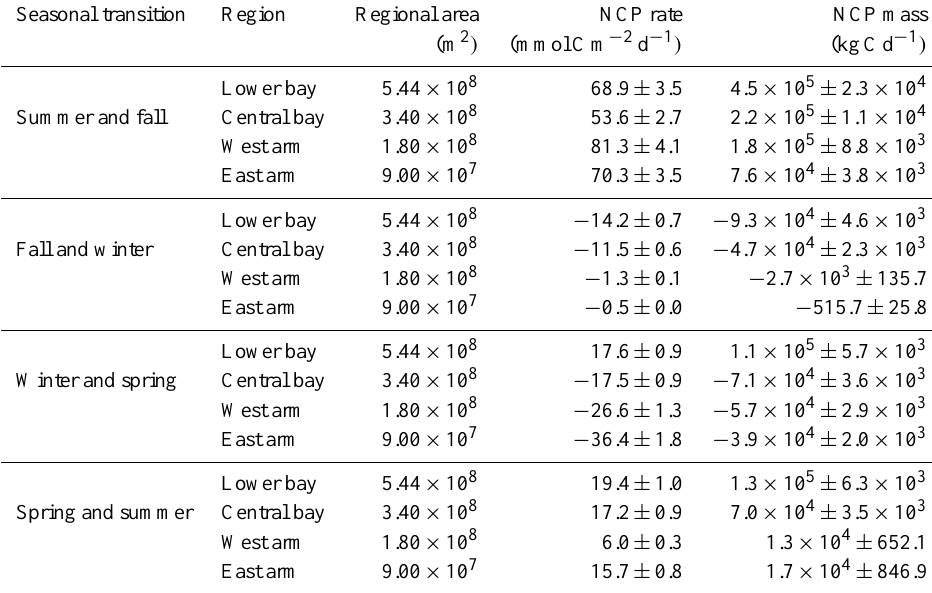
Table 1. Regional rates and masses of NCP – NCP by region in Glacier Bay based the change in salinity-normalized DIC concentrations between